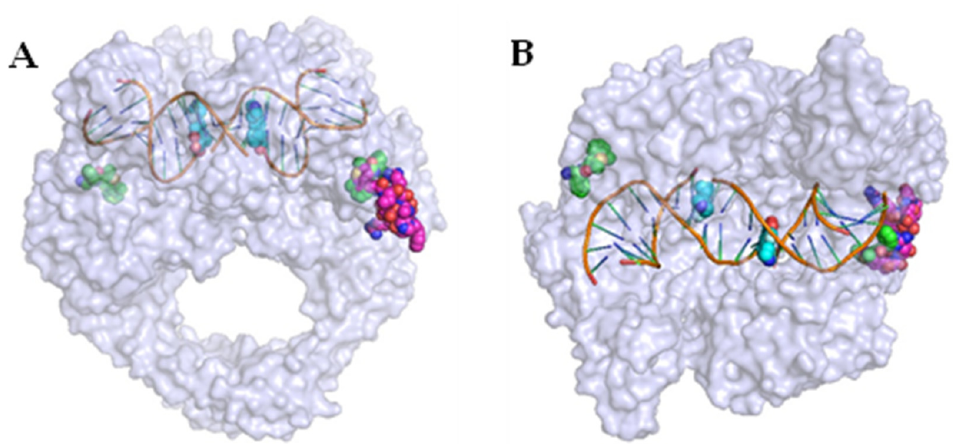
Figure 4. ( A ) Front view of superimposed DNA gyrase crystal structures highlighting the primary active site of ciprofloxacin (cyan spheres, PDB ID 2XCT [42]), and a novel allosteric site recently identified (green spheres, PDB ID 5NPP [41]). A further natural product, evybactin, was found to occupy the same allosteric site in Mycobacterium tuberculosis (magenta spheres, PDB ID 7UGW [43]). ( B ) Top view of the above-listed superimposed DNA gyrase crystal structures, rotated 90 ◦ forwards from ( A